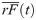
Temperature dependence of the association traces of BcO binding to AV and SAV.(A) Normalized fluorescence anisotropy, rF¯(t), temperature dependence of BcO (20 nM) binding to AV (260 nM) at pH 8, normalized as [rF(0) − rF(t)]/[rF(0) − rF(∞)]. The observed (color) and fitted (black line) curves at 25°C (top), 20°C (upper middle) and 15°C (lower middle) and 10°C (bottom) had half-times of 280 ms, 452 ms, 695 ms and 1024 ms, respectively; and (B) shows the corresponding semi-logarithmic plot of rF¯(t). (C) Normalized fluorescence anisotropy, rF¯(t), shows a temperature dependence of BcO (20 nM) binding to SAV (200 nM) at pH 8, normalized as above (4A). The observed (color) and fitted (black line) curves at 20°C (top), 15°C (middle) and 10°C (bottom) had half-times of 79 ms, 111 ms and 202 ms, respectively and (D) shows the corresponding semi-logarithmic plot of the rF¯(t).